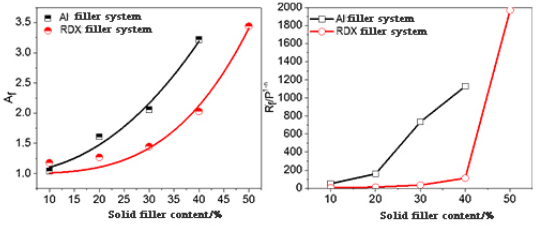
Figure 14. Changes of two-phase model parameters with the content of solid fillers.